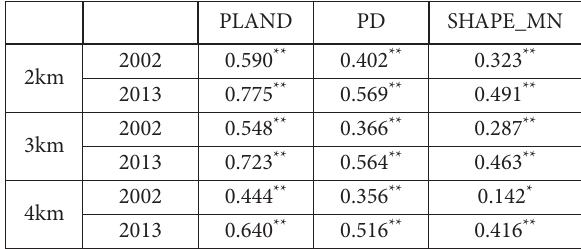
Note: ** Correlation is significant at the 0.01 level (2-tailed). * Correlation is significant at the 0.05 level